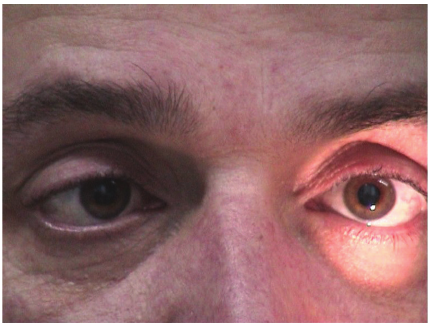
Figure 1: Bilaterally dilated pupils with absent response to light when light is shown to the left eye.